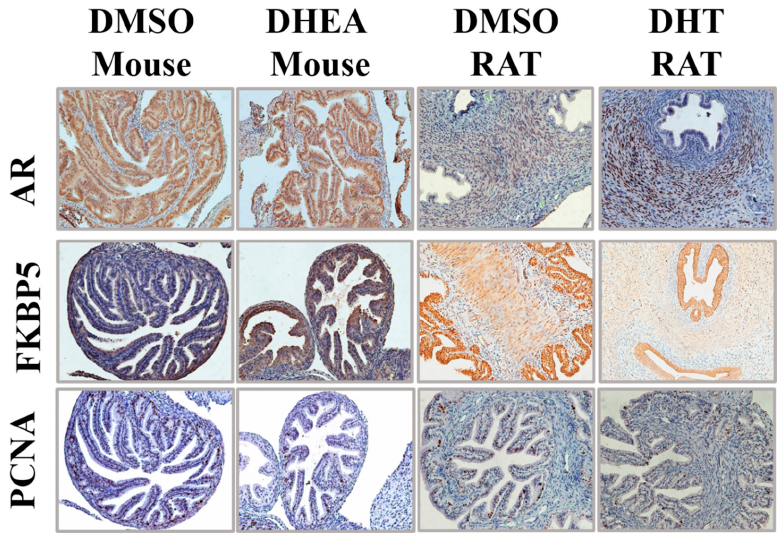
Figure 6. Rodent models of PCOS do not exhibit epithelial proliferation in the oviducts. Oviducts of DMSO or DHEA treated mice and DMSO or DHT treated rats were serially sectioned and stained for antibodies against androgen receptor (AR), FKBP5 or PCNA. Scale bar represents 100 μ